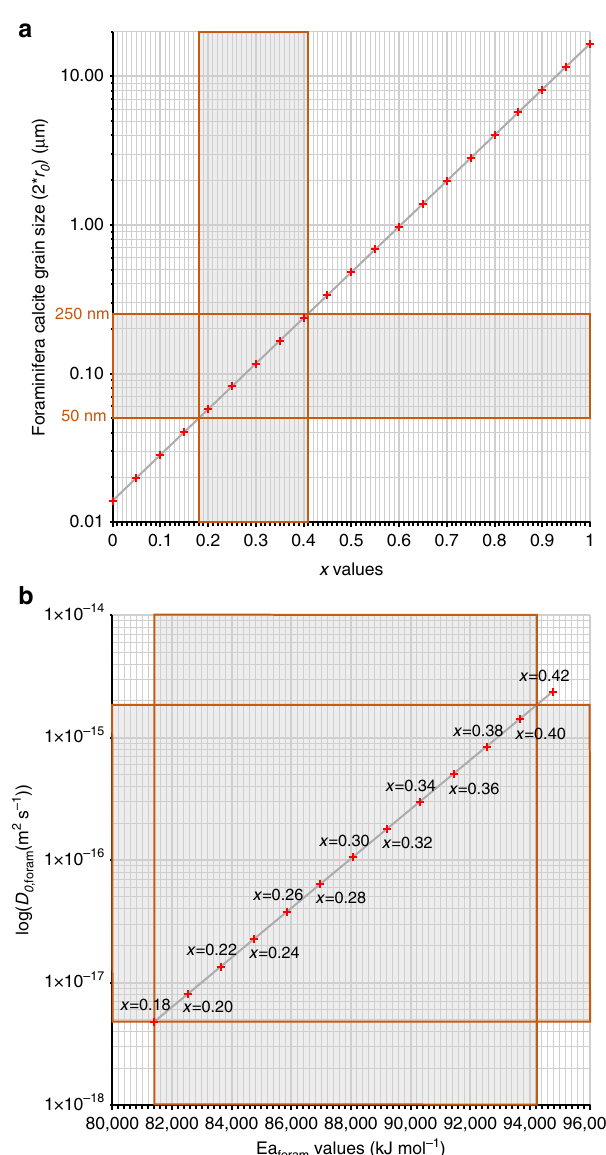
Fig. 5 Determination of the Ea foram and D 0,foram values for the oxygen solid- state diffusion in foraminifera calcites. a Foraminifera calcite grain sizes (2* r 0 values) obtained using Eq. (15) for the different x values (Eq. (16)). b D 0,foram and Ea foram values obtained using Eq. (16) for the different